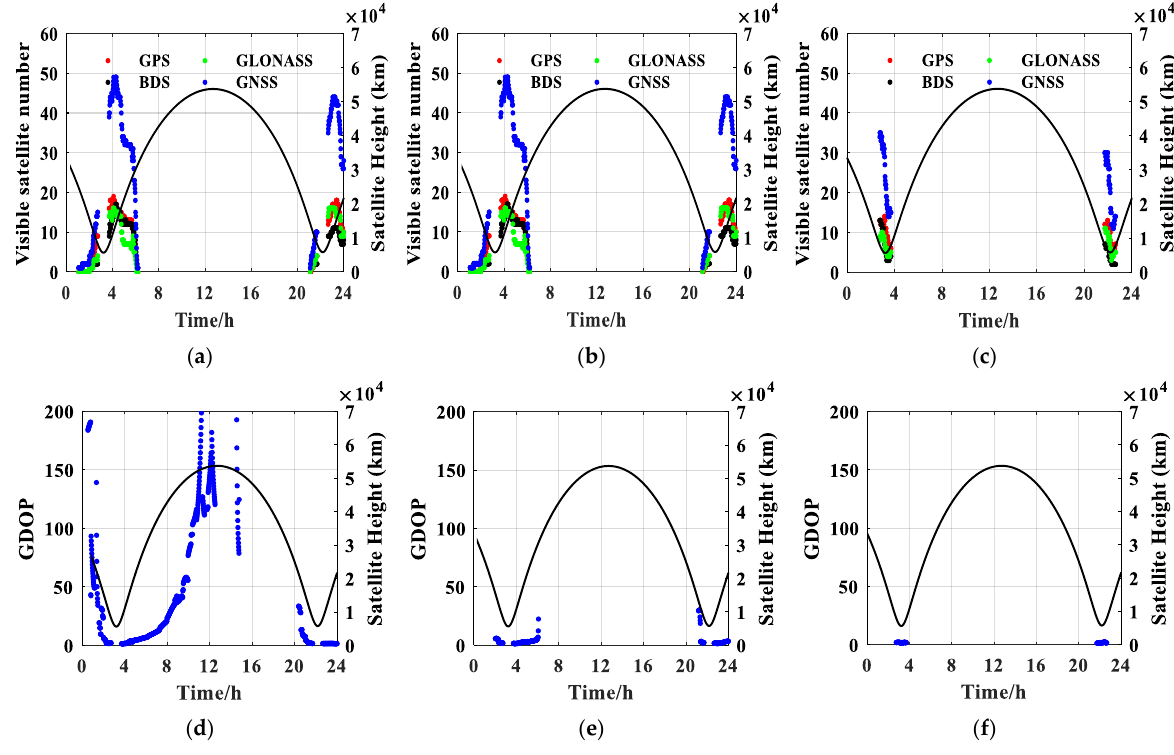
Figure 7. Visible GNSS number and GDOP of antennas 1, 2, and 3 ( a ) Visible GNSS number of antenna 1. ( b ) Visible GNSS number of antenna 2. ( c ) Visible GNSS number of antenna 3. ( d ) GDOP of antenna 1. ( e ) GDOP of antenna 2. ( f ) GDOP of antenna 3. Simulation data of transfer orbit with thrust are used to analyze the orbit determi- nation accuracy. The initial value is taken from the ephemeris on 25 July 2019, and the error of the solar pressure model is fixed at 10%, pseudorange noise is 10 m, phase noise is 0.03 m, and the measurement extraction interval is 5 min. The orbit determination and forecast accuracy are analyzed for 10 h by solving for and fixing the empirical force [61,62].